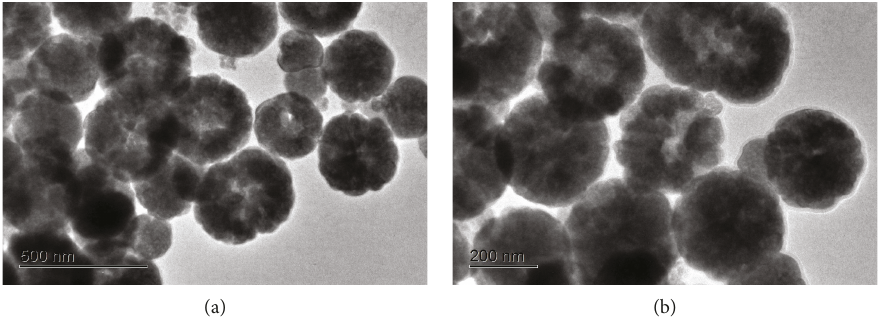
Figure 5: TEM micro images of Fe